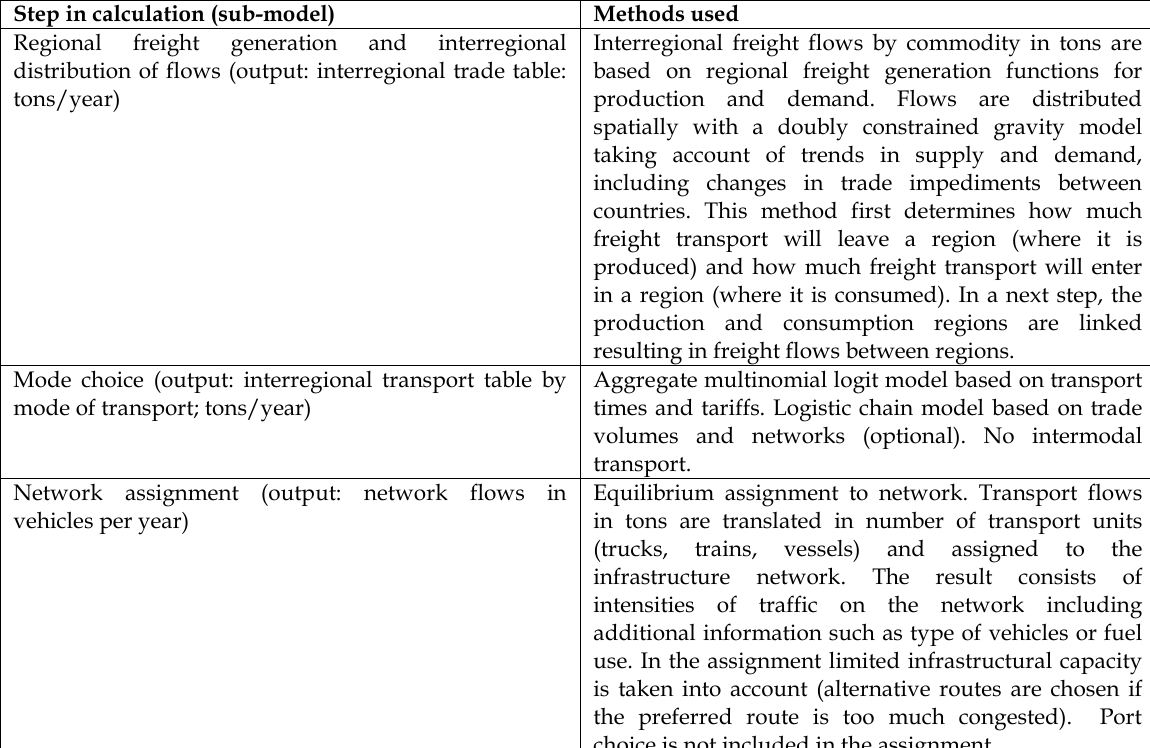
Table 3: the TRANS-TOOLS